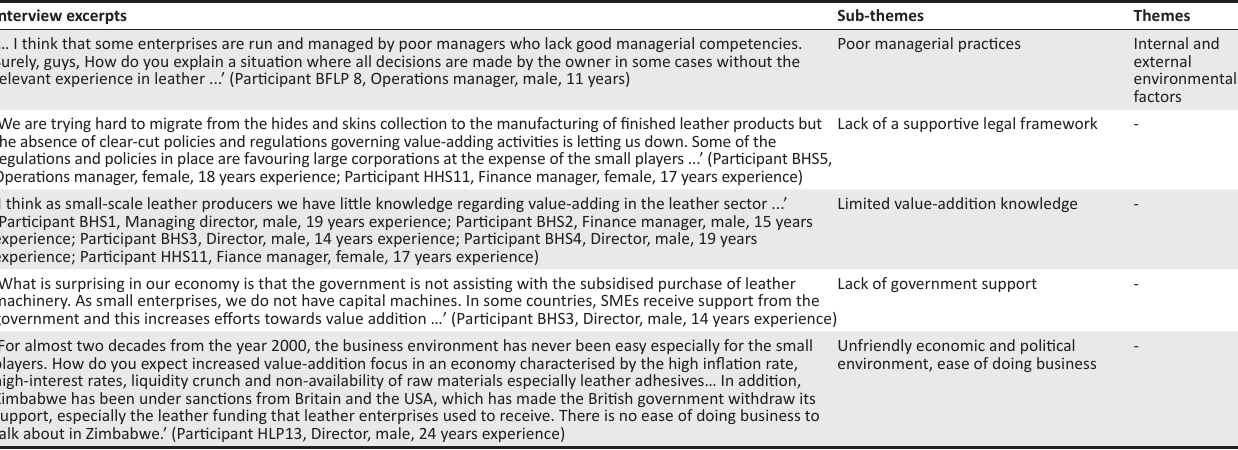
TABLE 5: Theme 3 internal and external environmental